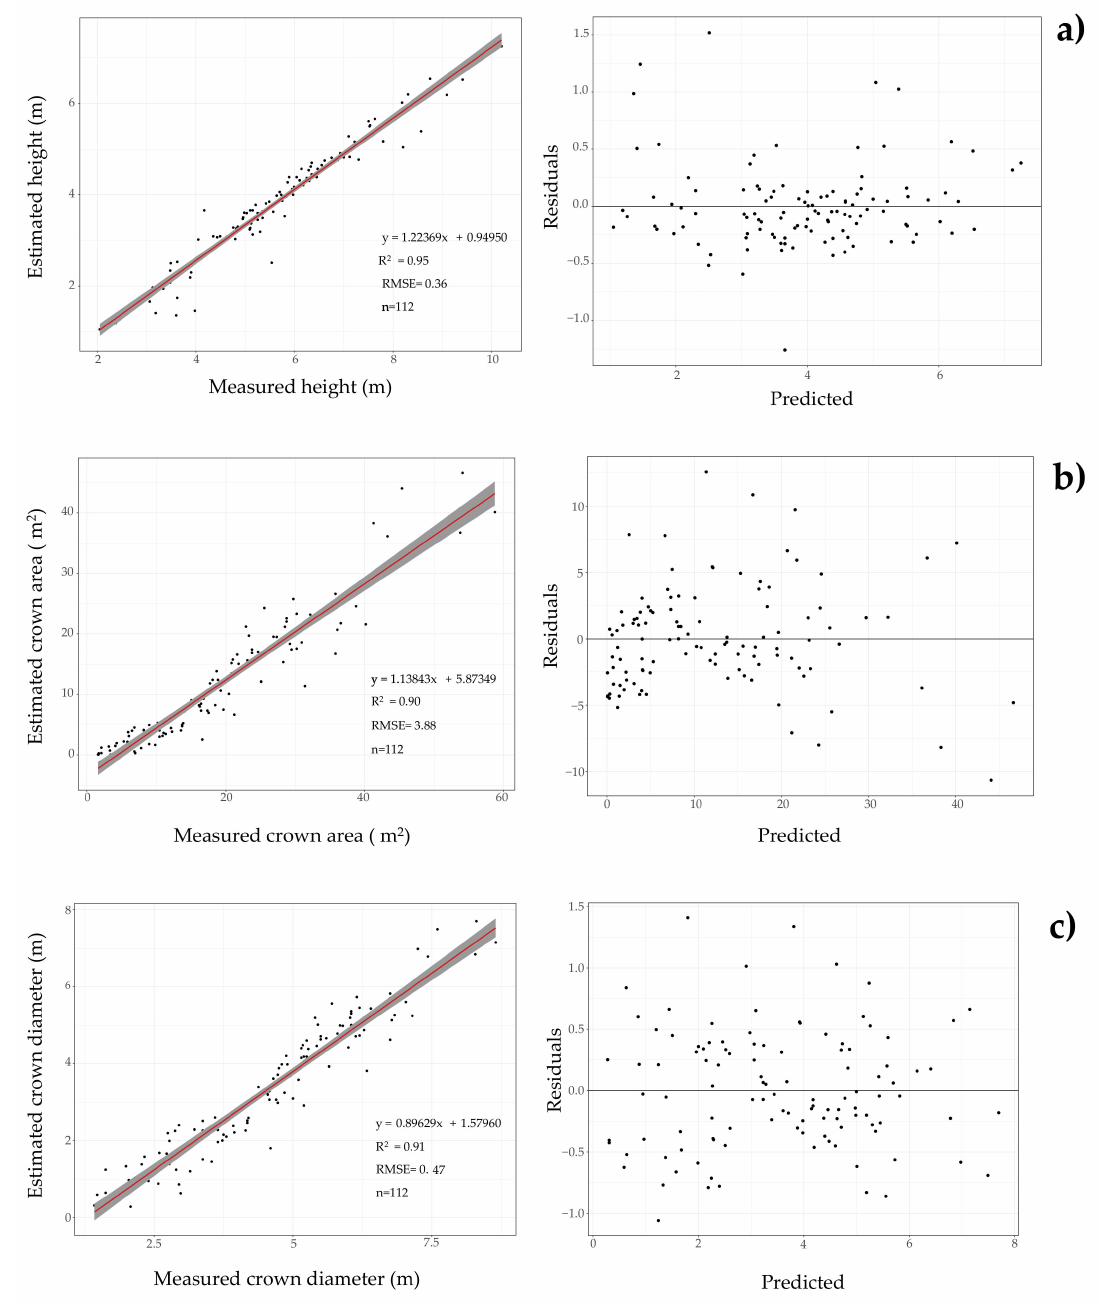
Figure 6. Regression analysis and graph of residues against predicted values for tree-level characteristics with field data vs. those estimated with UAV from 112 trees detected. ( a ) Height; ( b ) crown area; ( c ) crown